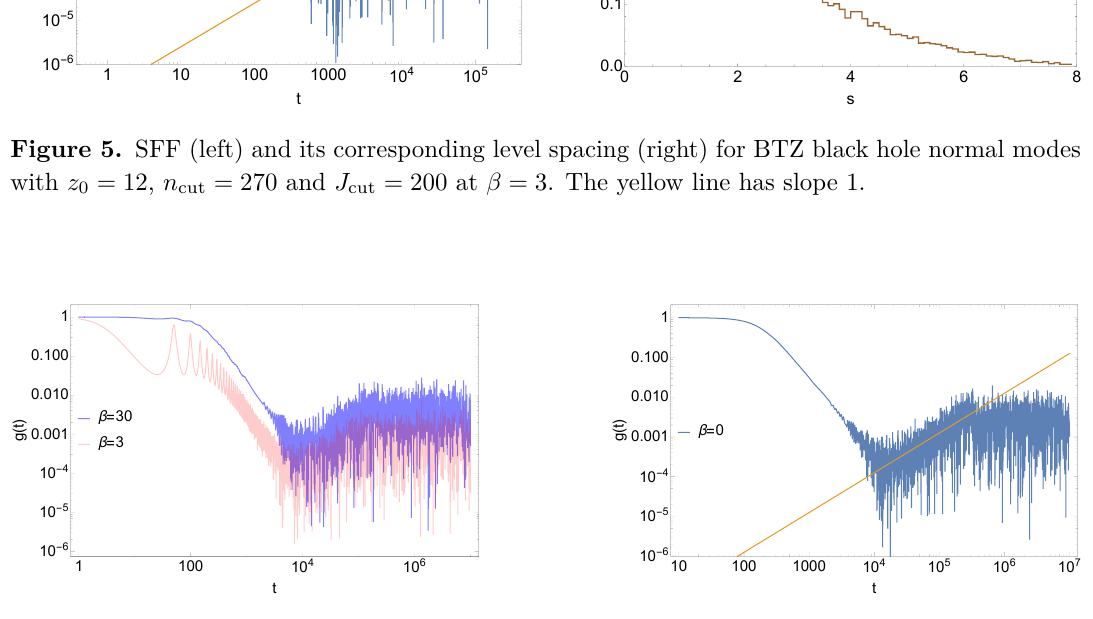
= 30 , β = 0 , J = 300 and n = 1 ) is contrasted 0 cut